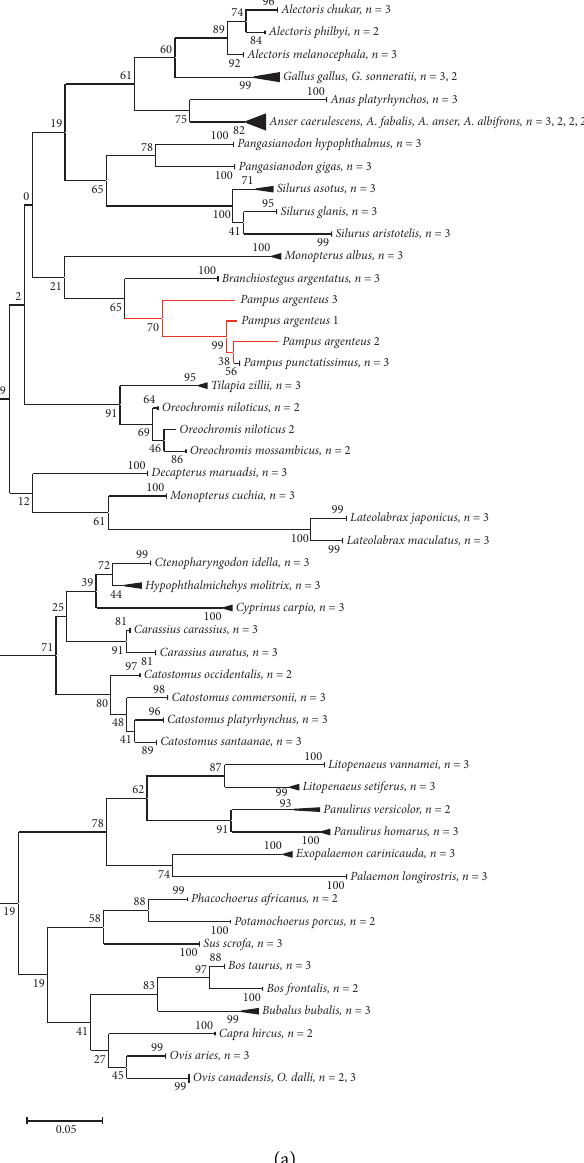
Figure 1: Phylogenetic trees of mini-barcode and standard barcode of COI are presented in (a) and (b),